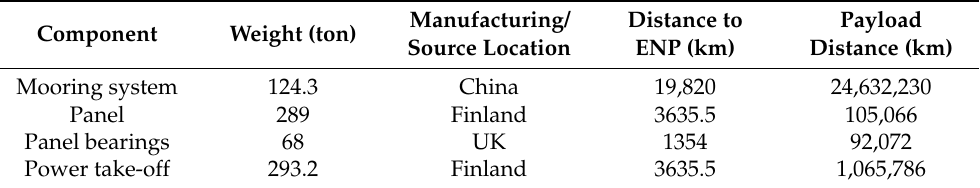
Table 2. Transportation requirements during final device assembly by cargo ship to Estaleiros Navais de Peniche (ENP).